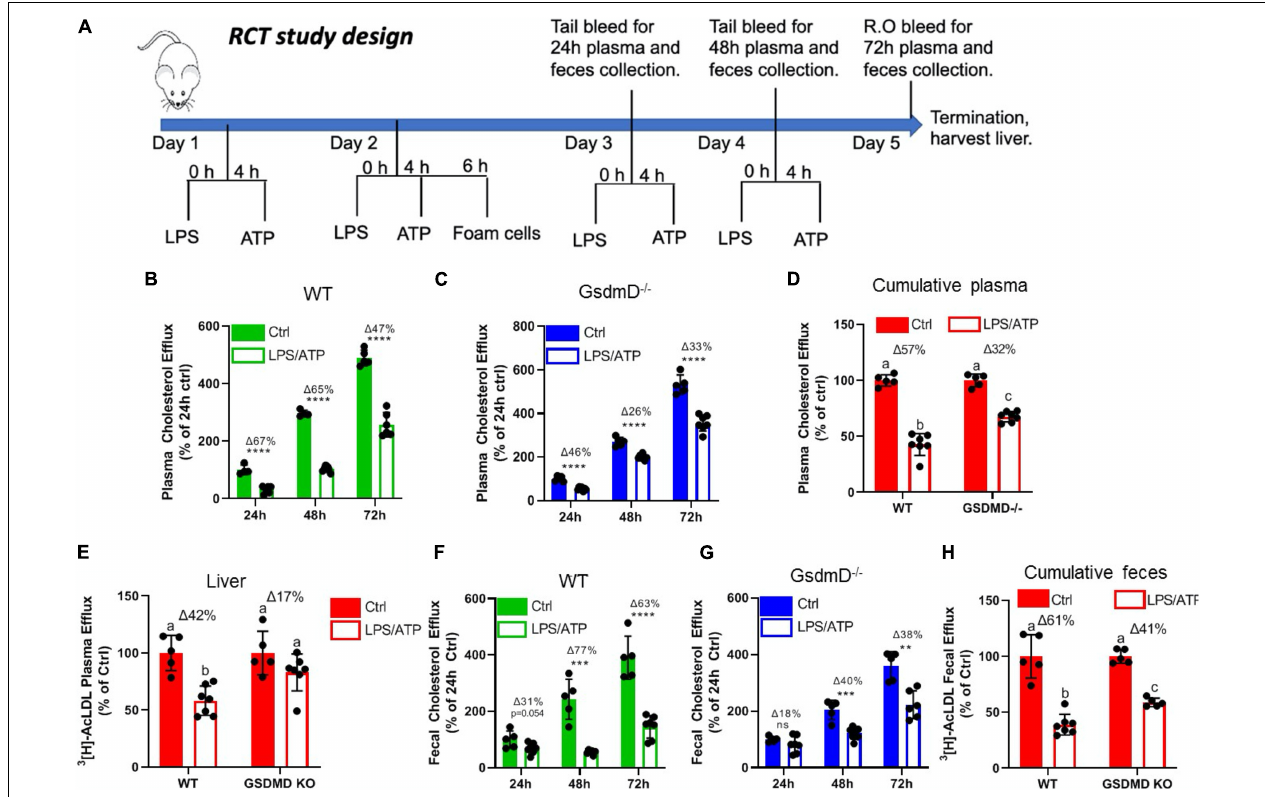
FIGURE 4 | Gasdermin D (GsdmD) mediates Nlrp3 inflammasome-induced defects in reverse cholesterol transport. (A) Schematic representation of mouse RCT study design. The 12-week-old male mice were injected daily with or without 5 ug LPS and 30 mM ATP for 4 days. On day 2 mice were injected with radiolabeled foam cells loaded with AcLDL and 3 H cholesterol. The plasma and feces RCT was assessed at 24, 48, and 72 h (quantified as a% of the 24 h Ctrl for each group) and cumulatively (quantified as a percent of respective Ctrl). (B) RCT to plasma in WT mice at 24, 48, and 72 h. (C) RCT to plasma in GsdmD - / - mice at 24, 48, and 72 h. (D) Cumulative RCT to plasma in WT and GsdmD - / - mice. (E) RCT to liver in WT and GsdmD - / - mice. (F) RCT to feces in WT mice at 24, 48, and 72 h. (G) RCT to feces in GsdmD - / - mice at 24, 48, and 72 h. (H) Cumulative RCT to feces in WT and GsdmD - / - mice. N = 4–5, for WT and GsdmD - / - Ctrl mice, N = 6–7 for WT and GsdmD - / - LPS/ATP mice. **** p < 0.0001, *** p < 0.001, ** p < 0.01 by two-tailed t -test. Groups with different letters a, b, c, d is p < 0.05 by One-way ANOVA.